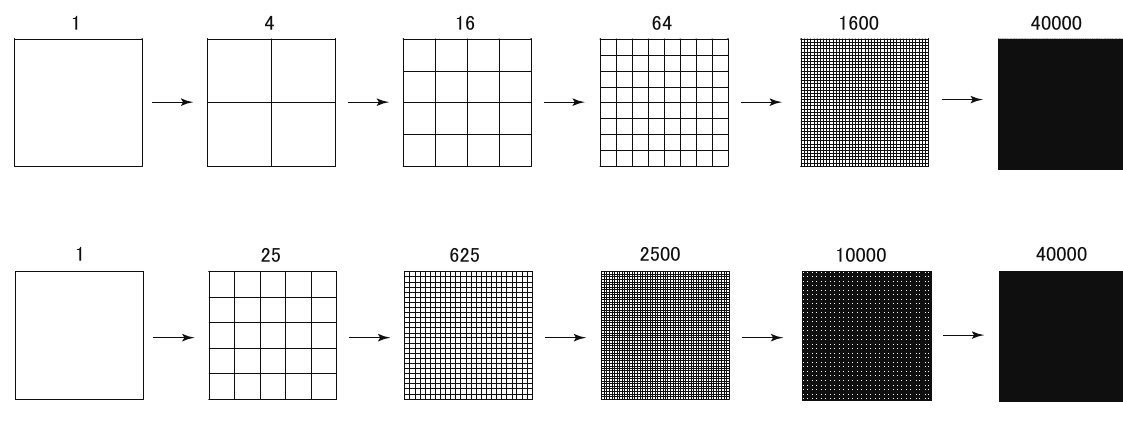
Figure 10. Two resolution classes used in the experiments. The upper sequence (class-1, C ) presents a different class than the lower sequence (class-2, C 1